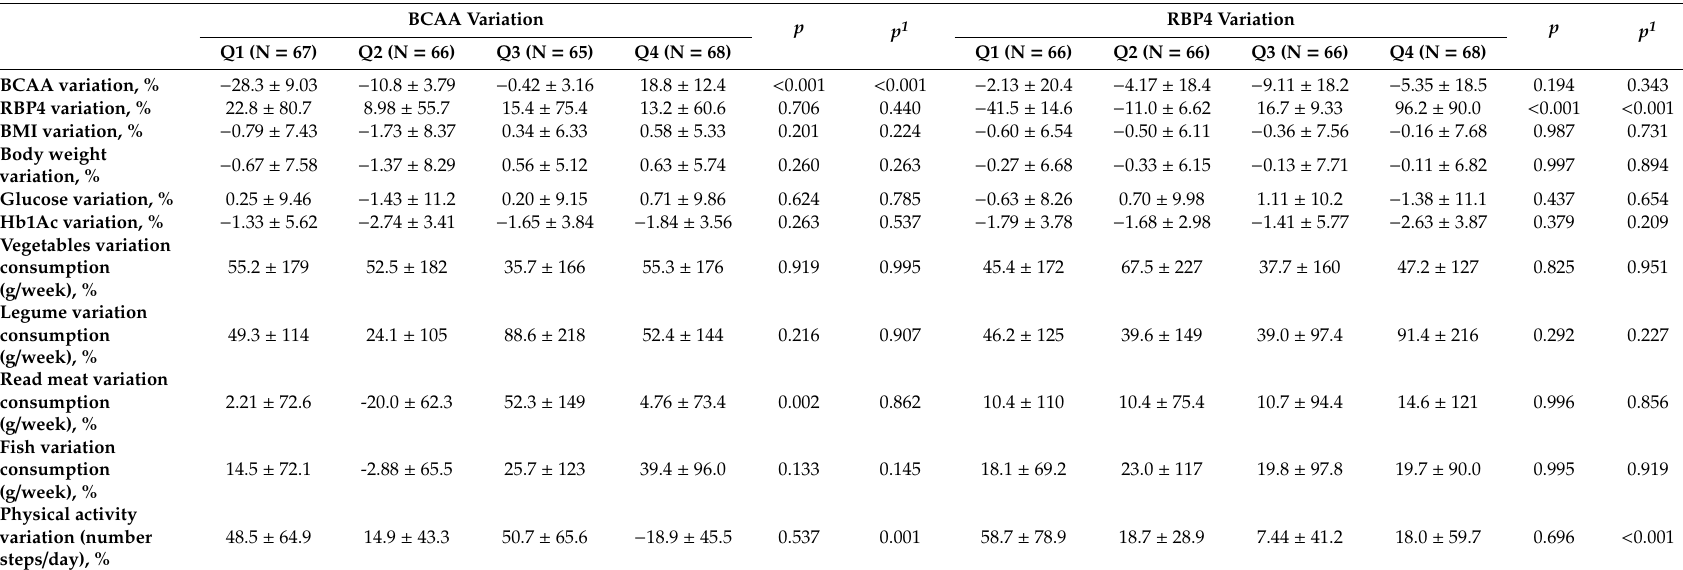
Table 4. Relationship between BCAA variation and RBP4 variation with variation of anthropometric, diabetic markers, dietary markers, and physical exercise parameters throughout the Feel4Diabetes study